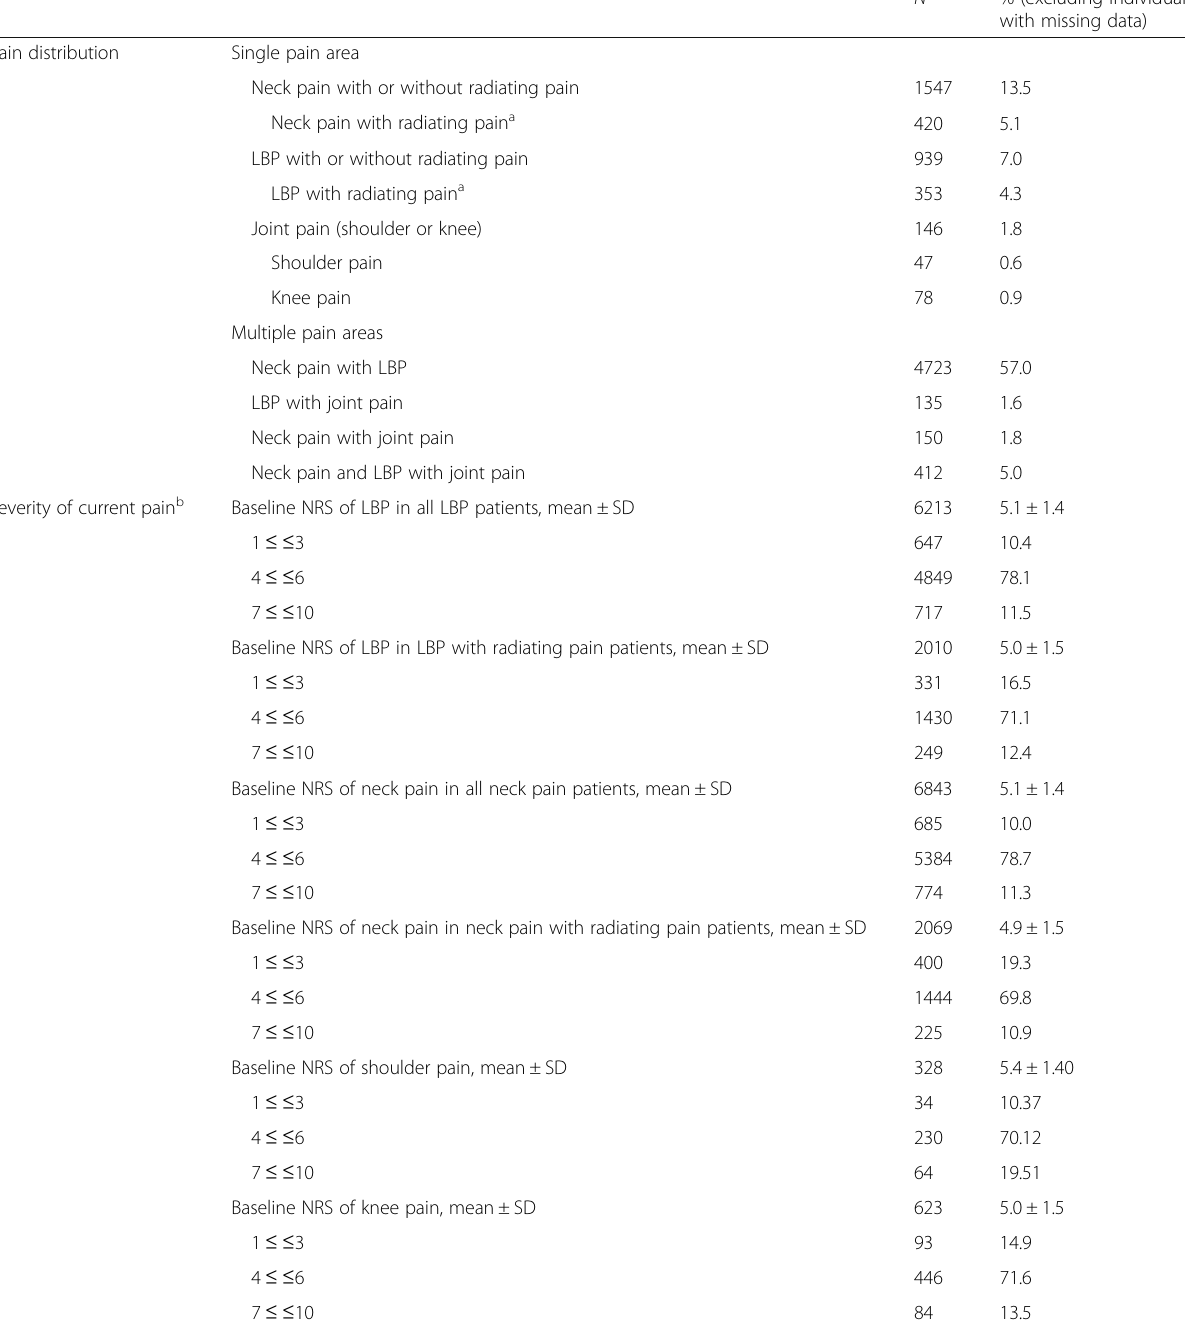
Table 2 Distribution of pain area and severity